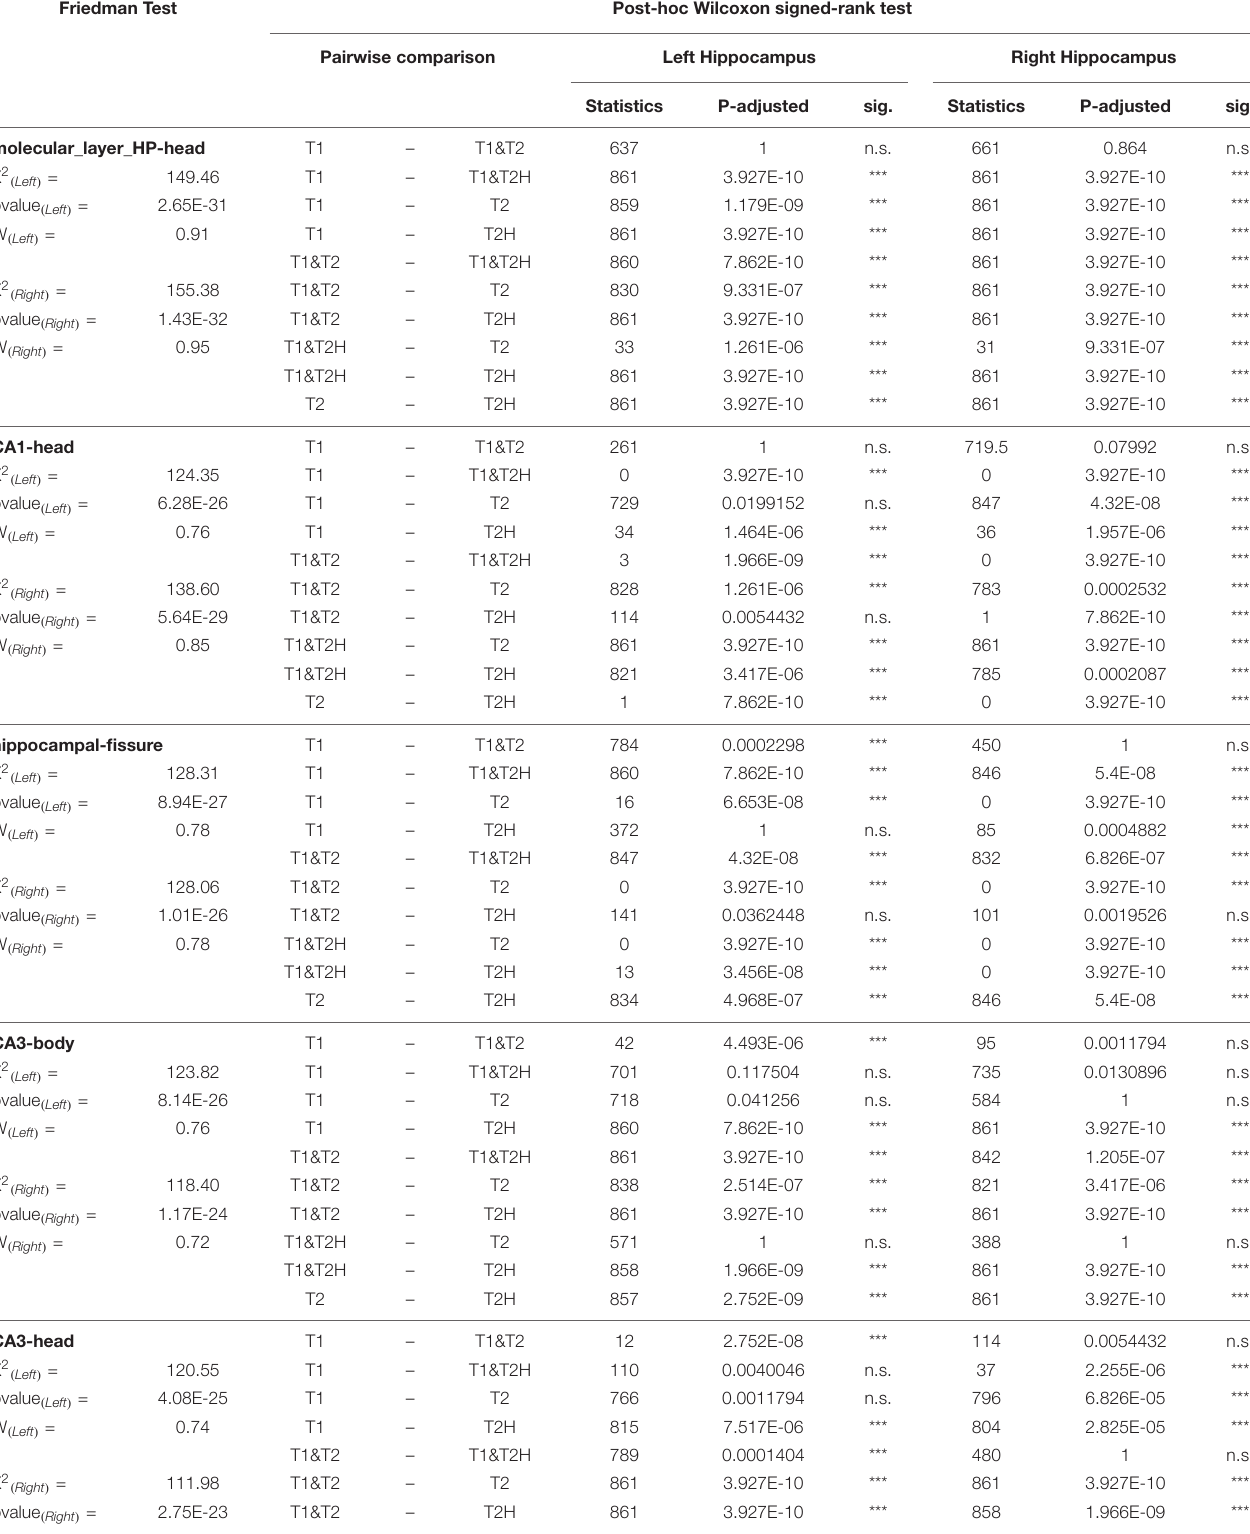
TABLE 1 | Friedman tests with pairwise Wilcoxon post hoc comparisons. Subfields are arranged according to the height of effect sizes of the Friedman test (X 2 ) using Kendall’s W. Friedman Test Post-hoc Wilcoxon signed-rank test Pairwise comparison Left